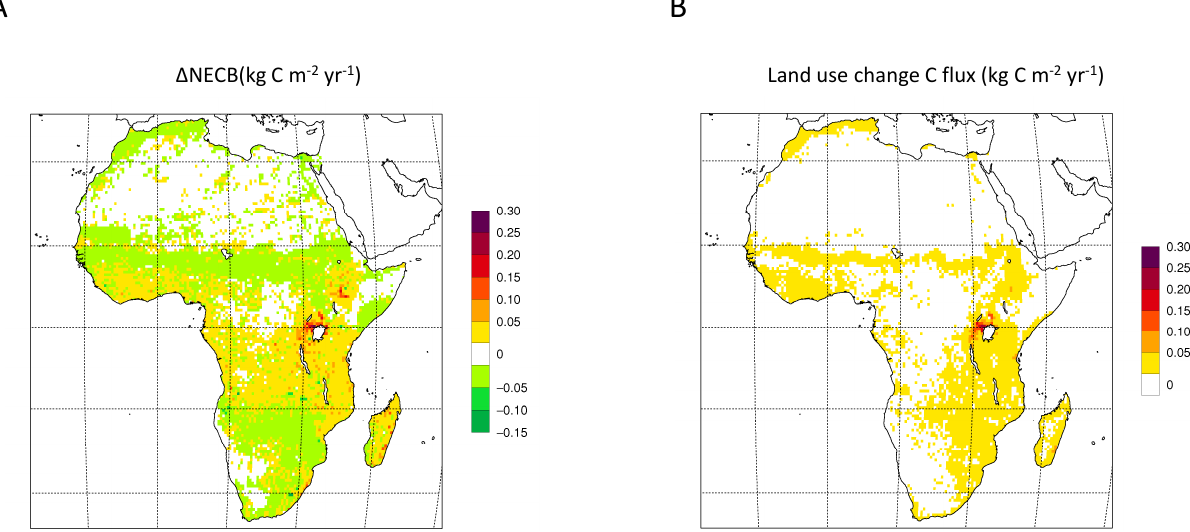
Fig. 12. (A) Difference in modelled net ecosystem carbon balance (NECB) between LP-GUESS with (simulation S1) and without (simulation S0) land use functionality (cropland and pasture representations and land use change). Positive values indicate grid cells where land use functionality reduces the carbon sink compared to potential natural vegetation only. (B) Carbon fluxes associated with land use change (not including carbon added to litter). The values are the means for the period 1961–1990. Positive values represent a flux to the